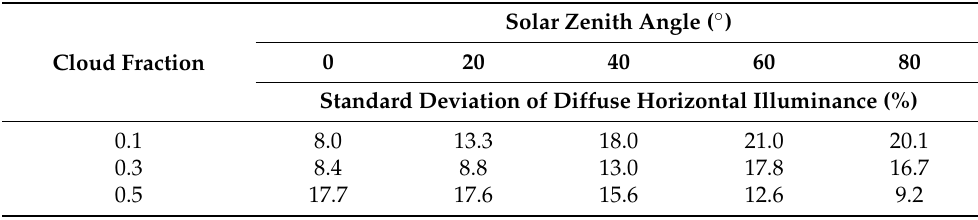
Table 1. Relative standard deviation of diffuse horizontal illuminance for the sample of 10 random cloud